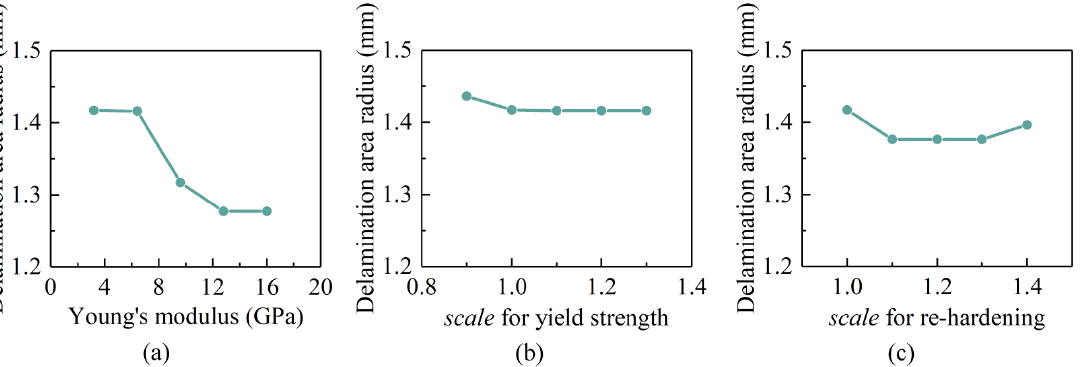
Figure 17. Dependence of the delamination area size on primer mechanical properties. ( a ) Young’s modulus, ( b ) yield strength, and ( c ) re-hardening modulus.